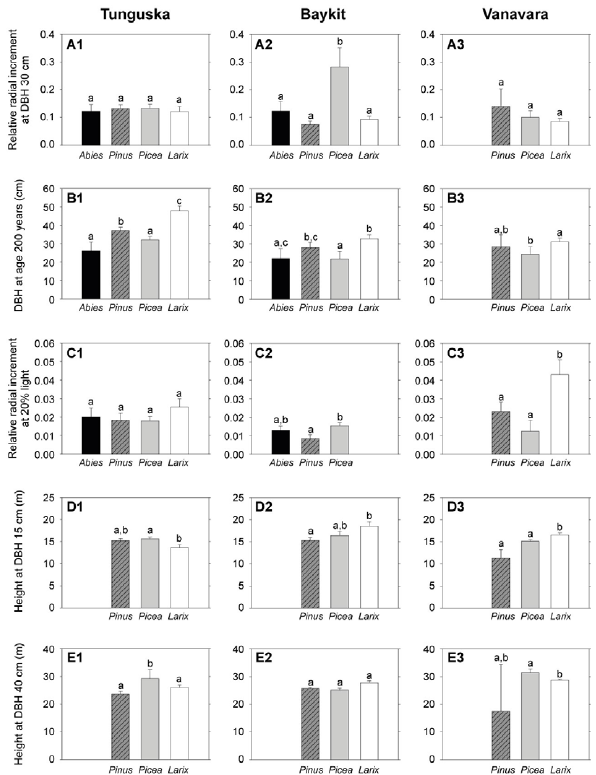
Fig. 6. Relative radial increment, DBH at age of 200yrs, relative radial increment at 20% light, height at DBH 15cm, and height at DBH 40cm for Abies , Pinus , Picea and Larix at the Tunguska, the Bajkit and the Vanavara sites. Different small letters indicate significant differences between